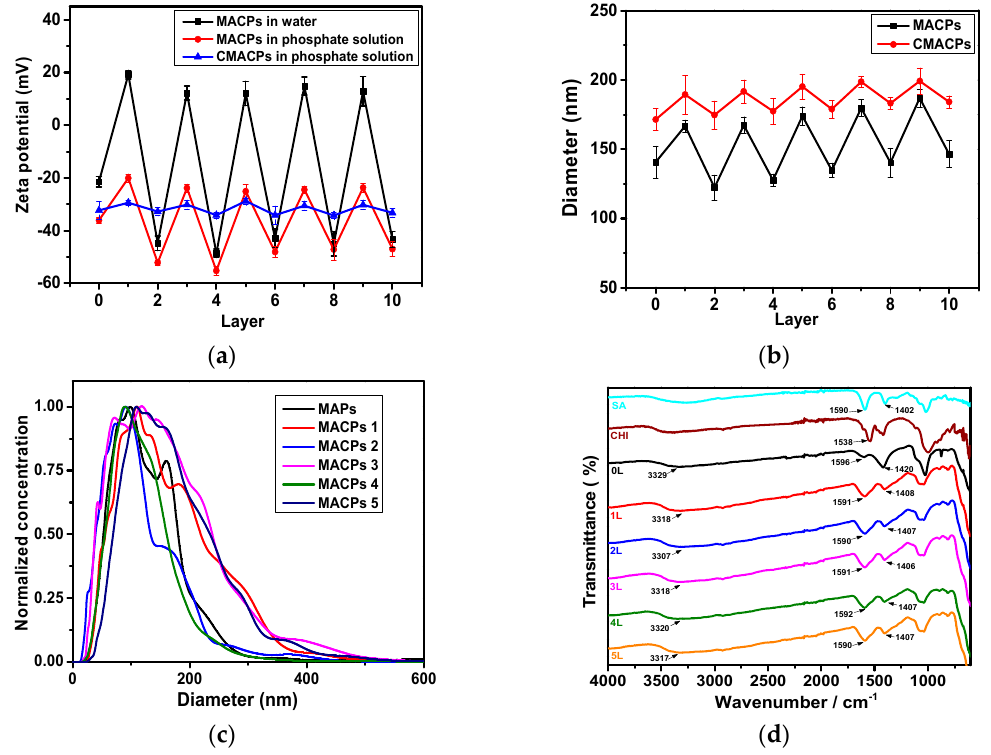
Figure 1. Zeta potential ( a ) and average diameter ( b ) of MACPs and CMACPs as a function of the number of coated layers. Zeta potential of particles was analysed in water (pH 7) and phosphate solution (10 mM, pH 7). Particle size was analysed in phosphate solution. Oscillations of zeta potential and average diameter were observed with the alternate coating of SA and CHI; ( c ) Size distribution of MAPs and MACPs with 1–5 layers of coated polymers; ( d ) FTIR spectra of MAPs and MACPs with the number of deposited polymer layers from 1 to 5. The results are shown in mean ± SD, n ≥ 3.